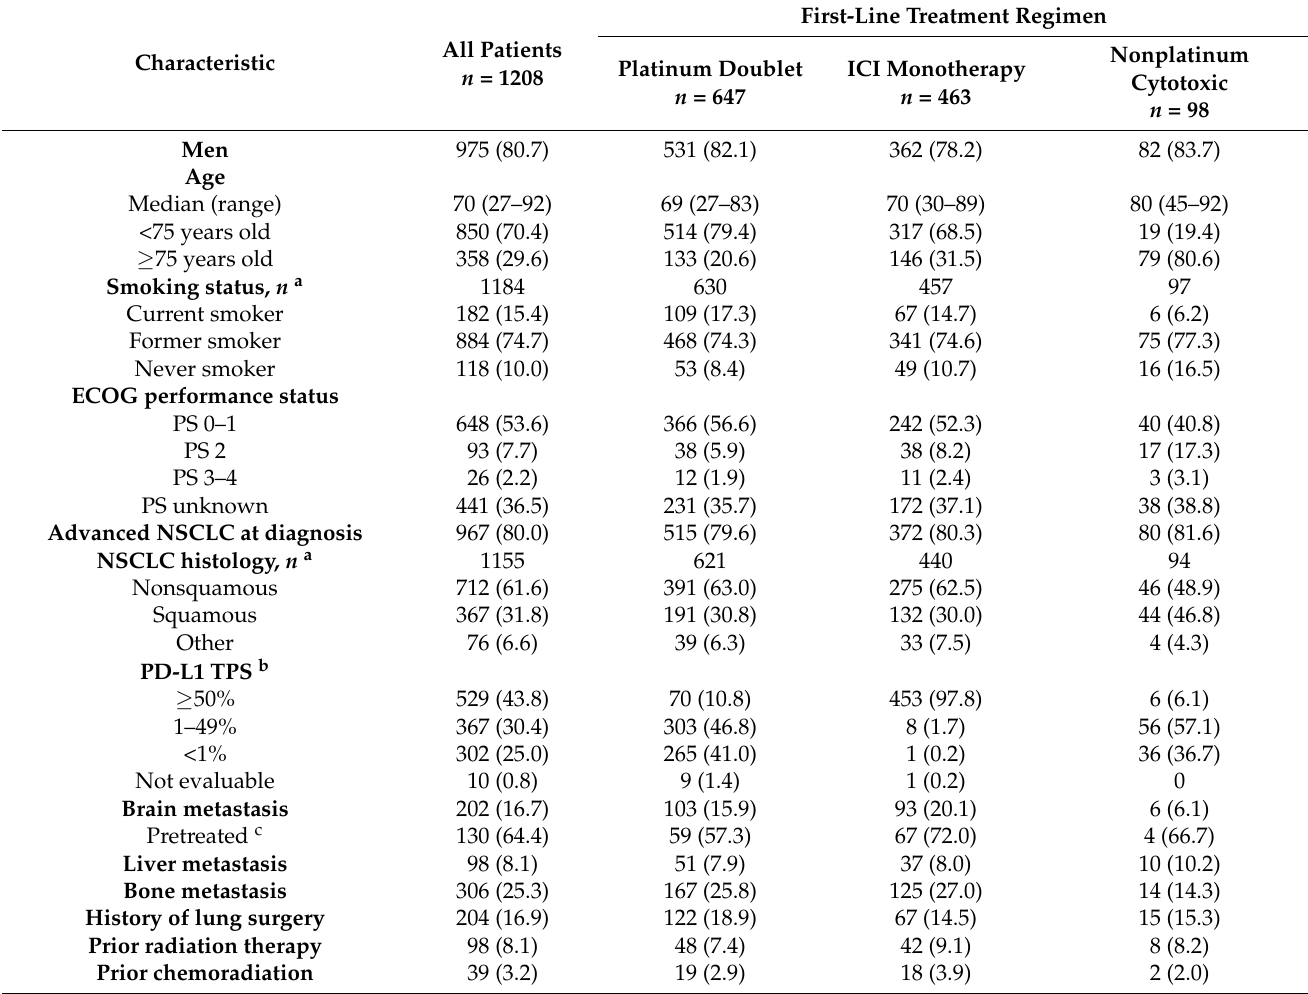
Table 1. Baseline patient characteristics overall and by first-line systemic therapy